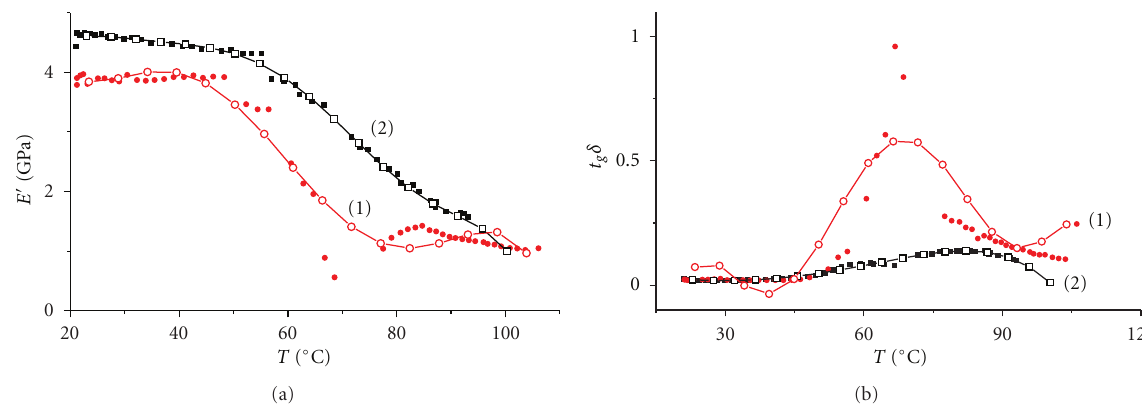
Figure 6: Temperature dependence of storage modulus E (cid:4) (a) and the mechanical-loss tangent (b) for amorphous (1) and crystalline (2) films of the CPL1/130 ◦ C sample.